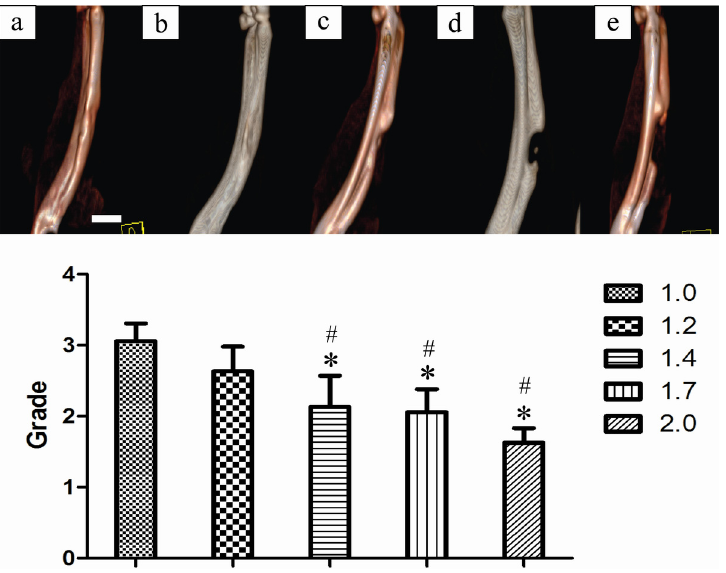
Fig 6. Radiographic grades of 1.0-cm and 1.2-cm groups showed more new bone formation on the Computer tomograph (CT). CT scans of different radial defects 12 weeks postoperatively. * P < 0.05 compared with 1.0-cm groups, and # P < 0.05 compared with 1.2-cm groups. Column graph b (1.2-cm group) showed no statistically significant difference with column graph a (1.0-cm group) ( P > 0.05). (a: 1.0cm, b: 1.2cm, c: 1.4cm, d: 1.7cm, e: 2.0 cm, scale bar: 10mm, Grade: value of